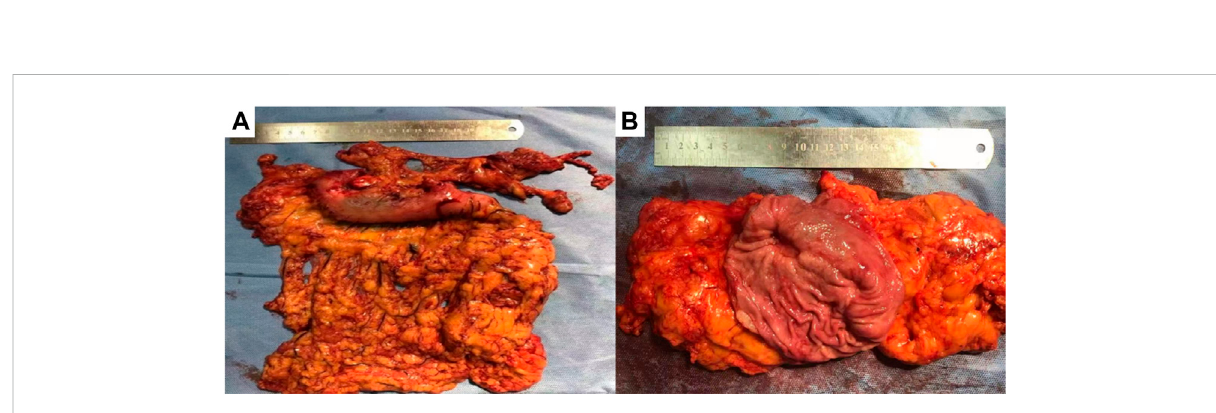
FIGURE 6 Grossspecimenafterresection, (A) showedtheexteriorviewwithoutserosainvasion, (B) showedtheinteriorview,gastricmucosalulcer,about 2*1.5 cm in size, without breaking through the